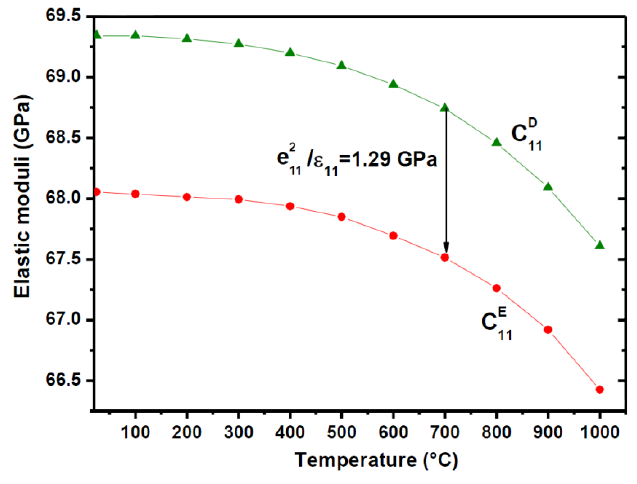
Figure 4. Thermal dependence of pure and piezoelectrically stiffened C of flux-grown α-GeO . Errors are smaller than the symbol 2